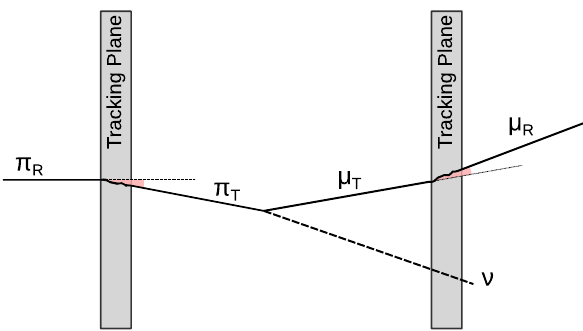
Fig. 2 Schematic describing the hypothesis made on the achievable resolutions on π ± and μ ± direction. At the decay point, the recon- structed π ± and μ ± directions, π R and μ R , differ from the true ones, π μ π ± and μ ± undergo multiple coulomb scattering in T and T , as the the last and first tracking plane they respectively cross